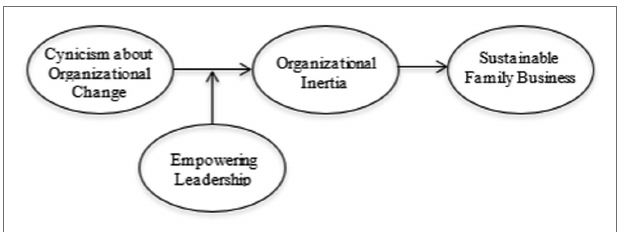
FIGURE 2 | Hayes v3.5 Model-7 output statistical diagram. **Correlation values are significant at p < 0.01.